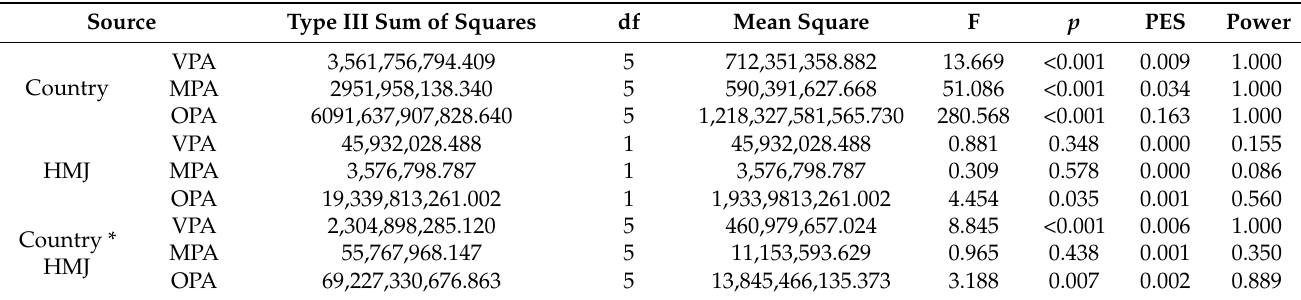
Table 3. Tests of between-Subjects Effects [ n =